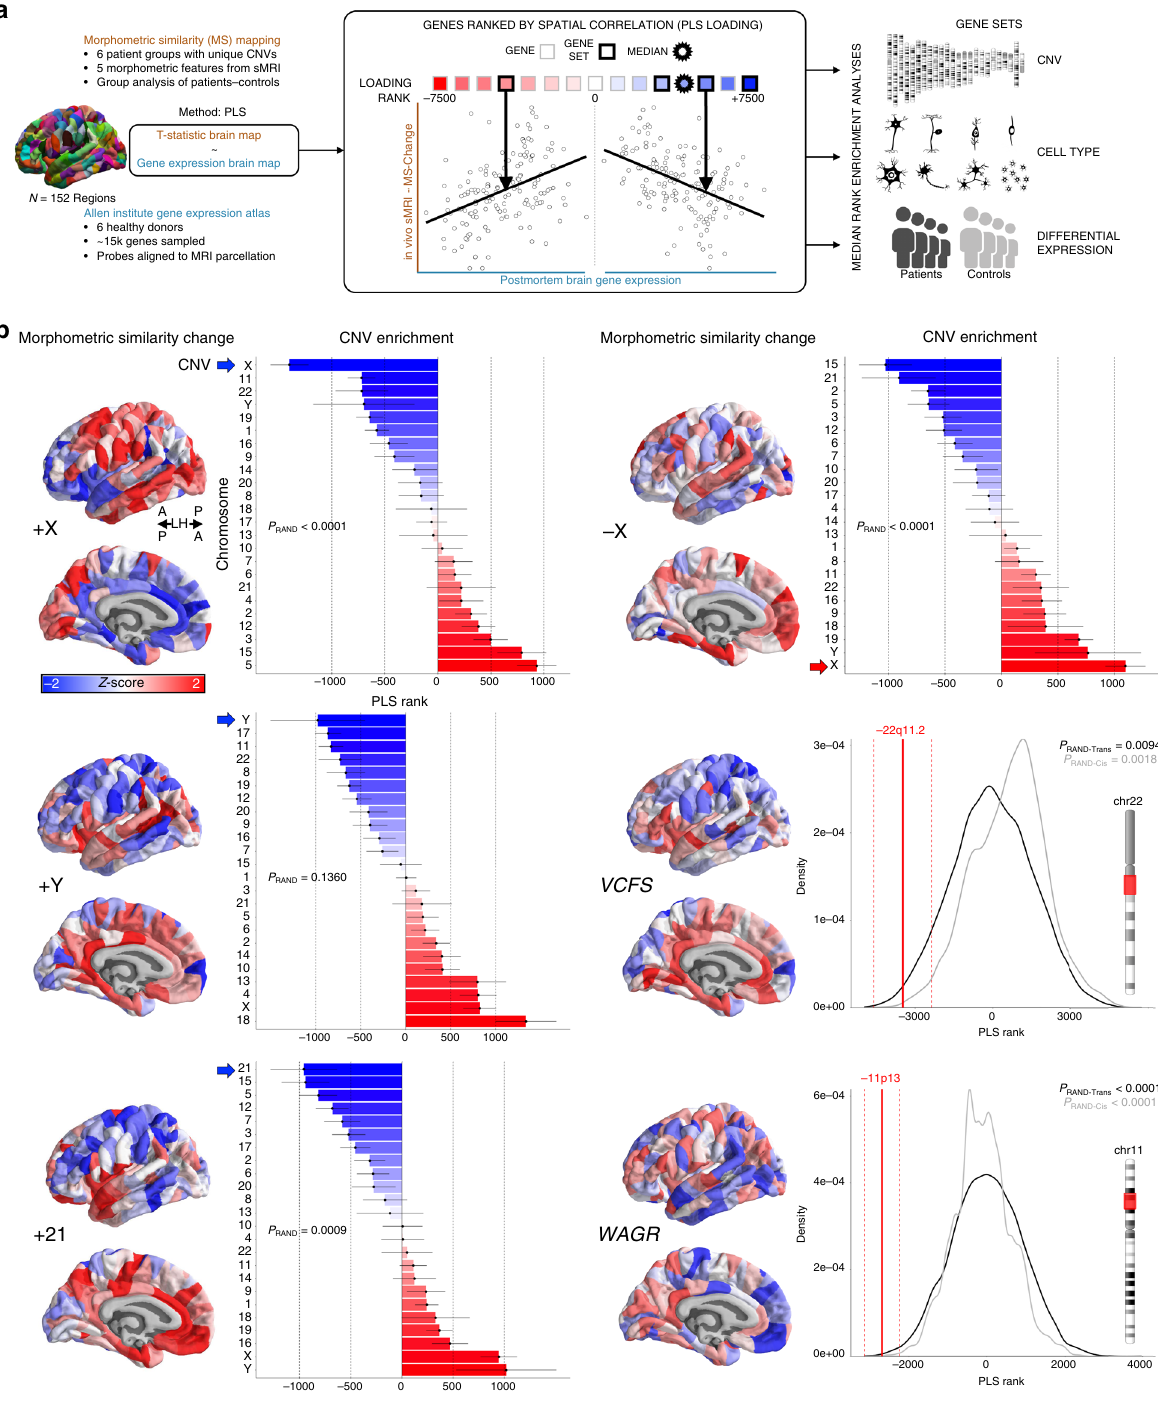
(cid:129) Group analysis of patients–controls Method: T-statistic brain map ~ Gene expression brain map N = 152 Regions